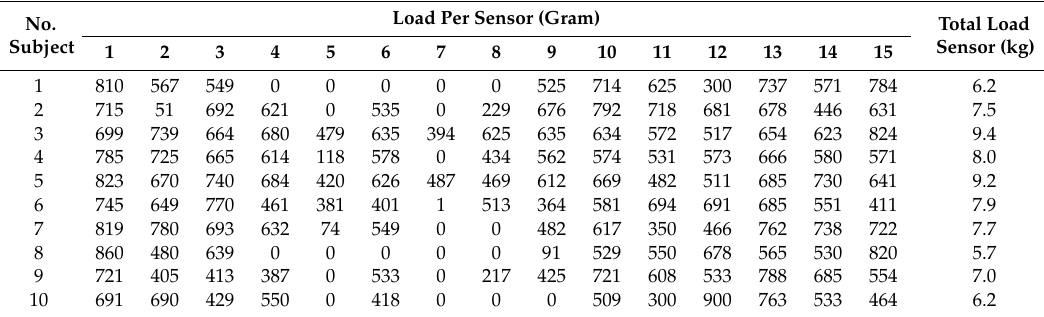
Table 4. Load data on the soles of right leg 10 research